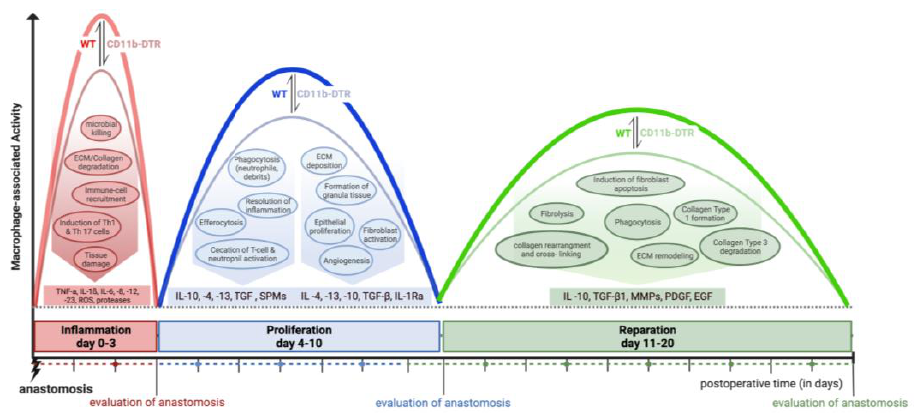
Figure 1. Graphical overview of the study design and macrophage-associated activities during intestinal anastomotic healing. Wild type (WT), CD11b diphtheria toxin receptor (CD11b-DTR), extracellular matrix (ECM), tumor necrosis factor alpha (TNF- α ), interleukin (IL1-ß, -4, -6, -8, -10, -12, -13, -23), reactive oxygen species (ROS), transforming growth factor (TGF), specialized pro-resolving mediator (SPM), matrix metalloproteinases (MMP), platelet-derived growth factor (PDGF), epidermal growth factor (EGF).